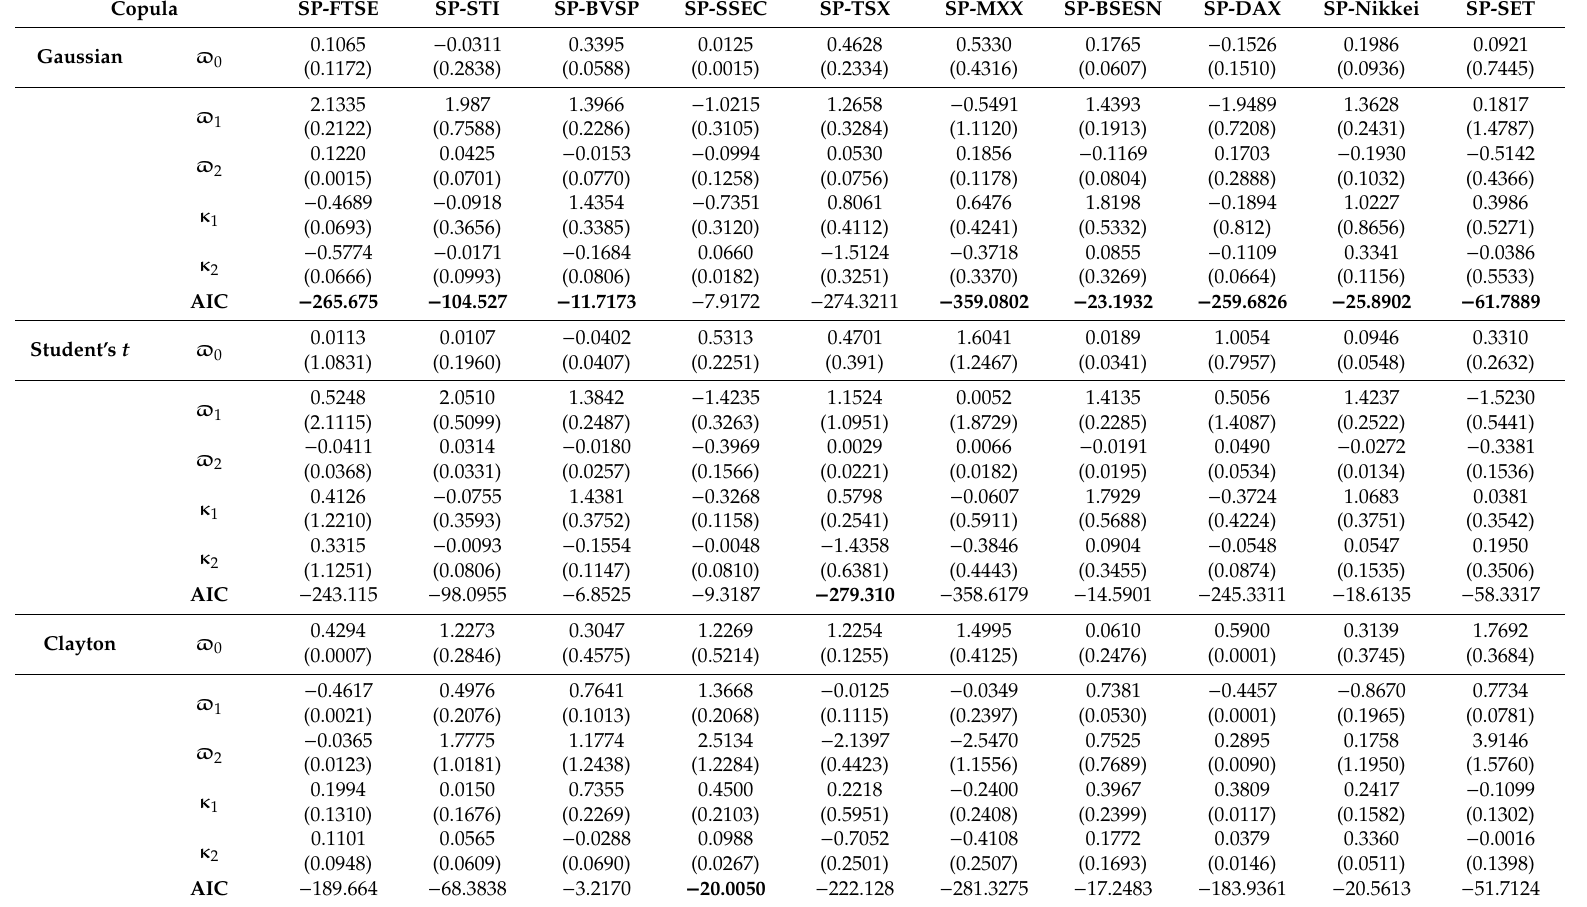
Table 7. Estimation of dynamic copula with